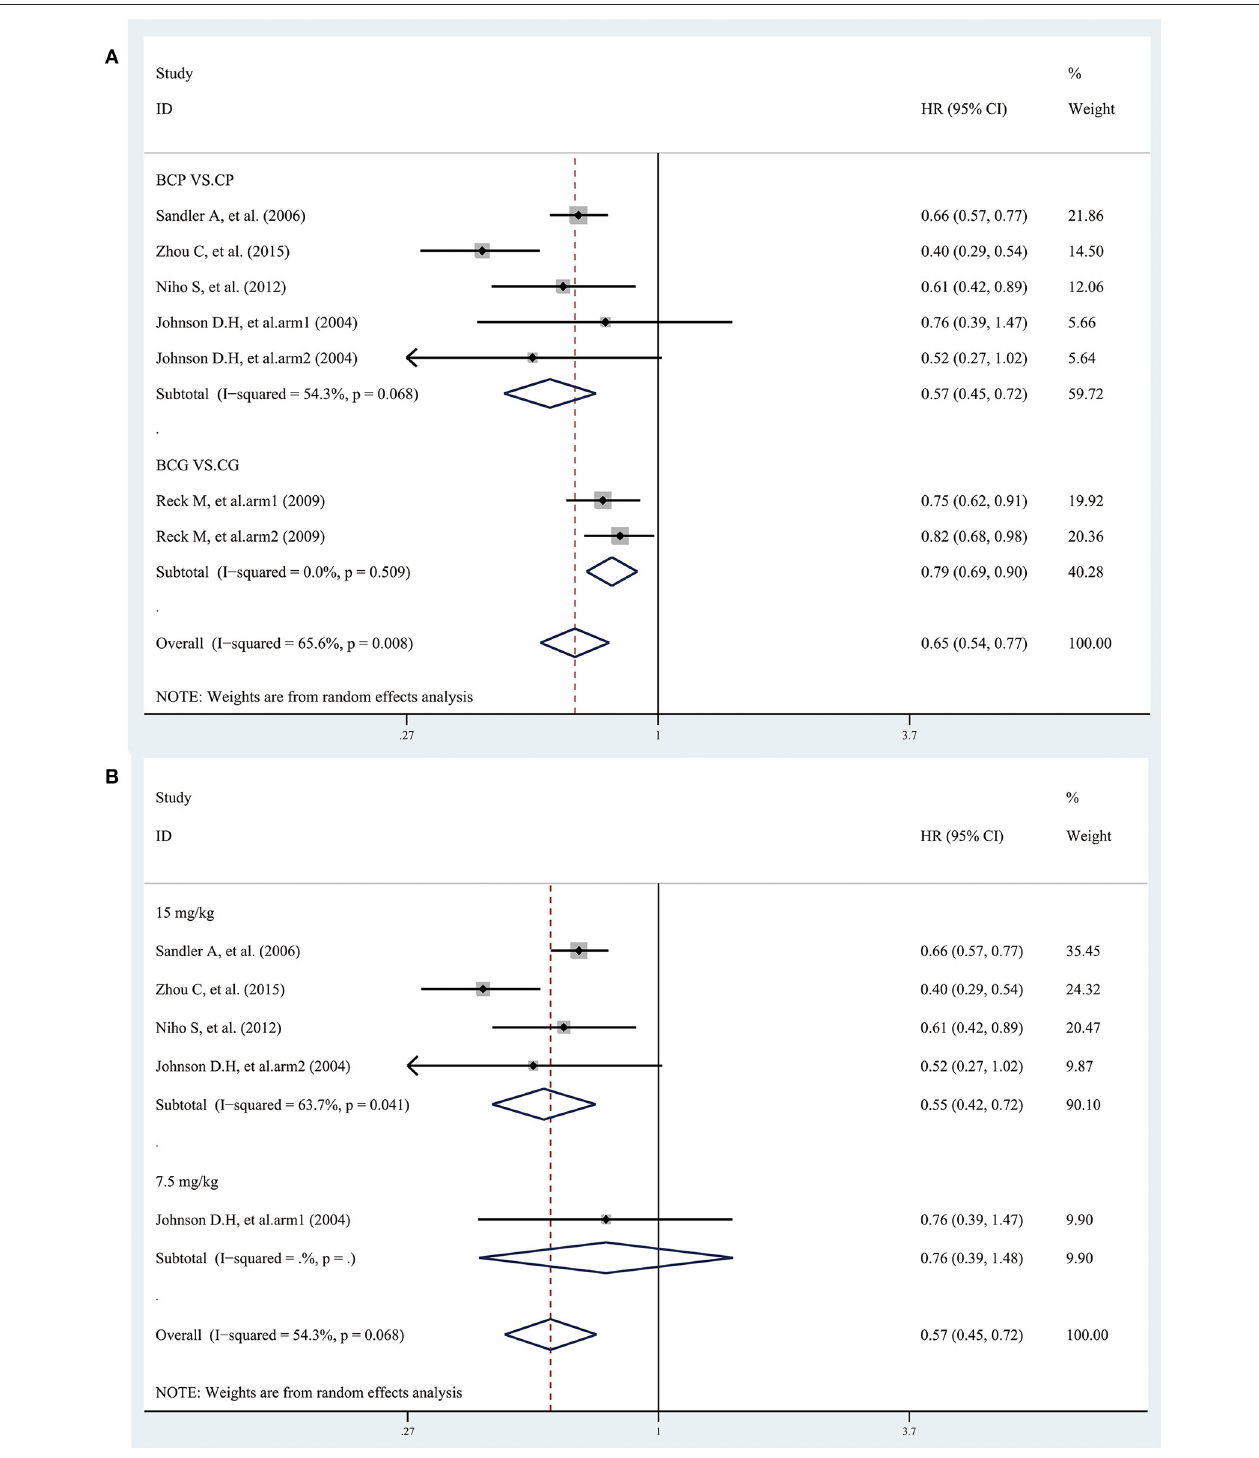
FIGURE 4 | Forest plots of hazard ratios (HRs) for progression-free survival (PFS) based on (A) treatment and (B) bevacizumab dose (7.5 mg/kg and 15 mg/kg) from randomized controlled trials of bevacizumab added to standard chemotherapy, compared with chemotherapy alone, as first-line therapy in patients with advanced